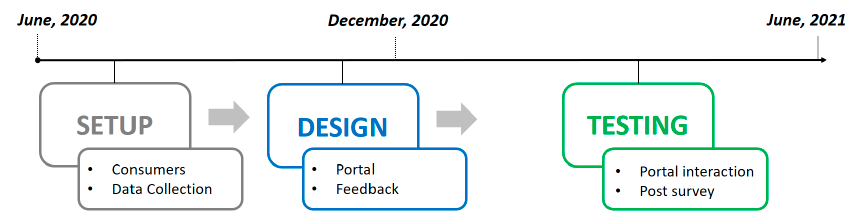
Figure 2. Methodological steps with